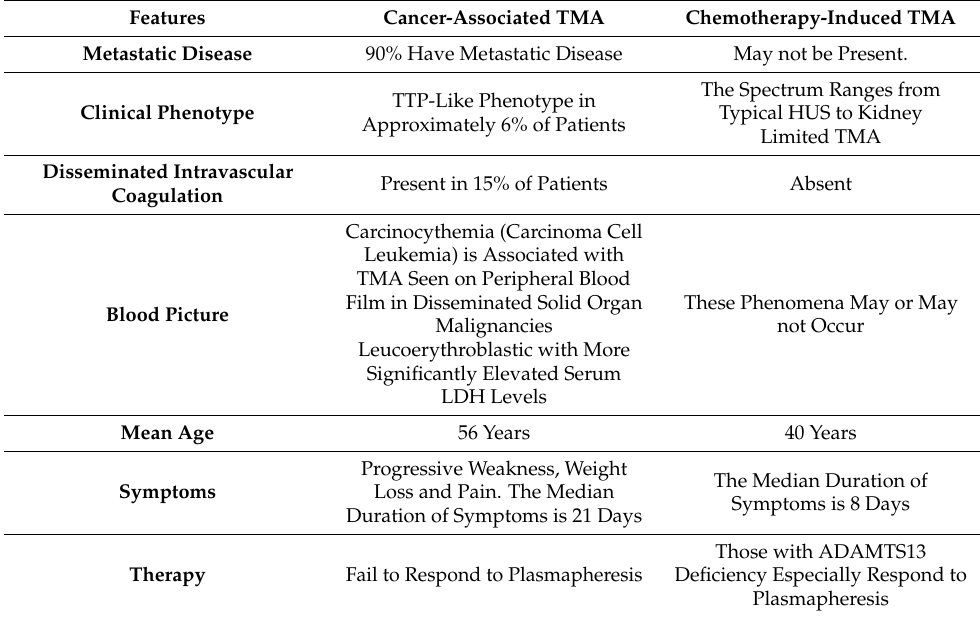
Table 2. Key differences between cancer-related and chemotherapy-related TMA [46,50–53]. TTP: thrombotic thrombocytopenic